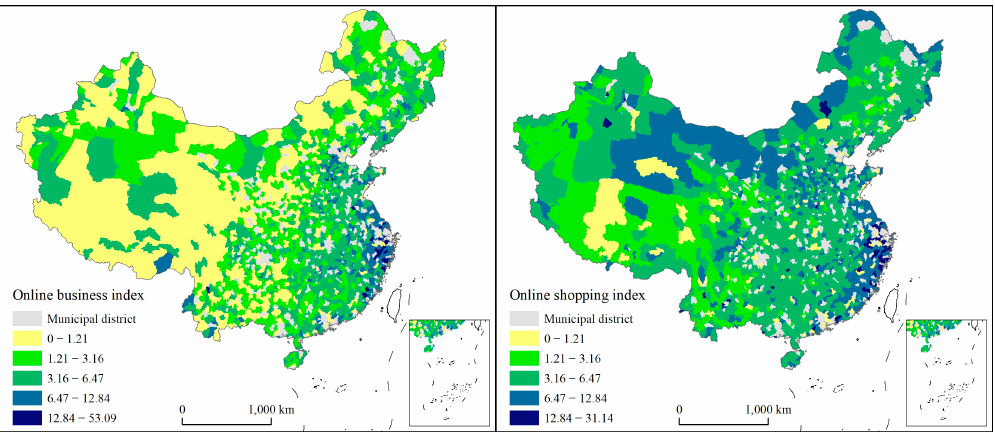
Figure 1. County-level online business and online shopping index in